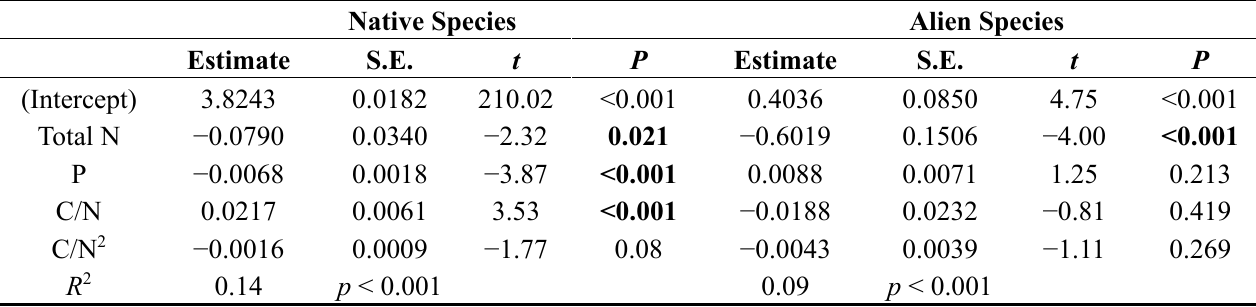
Table 2. Main effects models with the number of native and alien plants as a response to ecological variables, respectively.